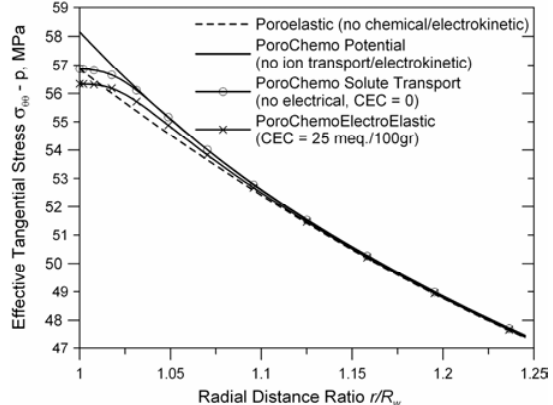
Fig. 11 – Effective tangential stress distribution in the formation after t = 15 minutes into drilling for low mud activity (high mud f . 87 < a f . 90. salinity): a o = 0 mud = 0